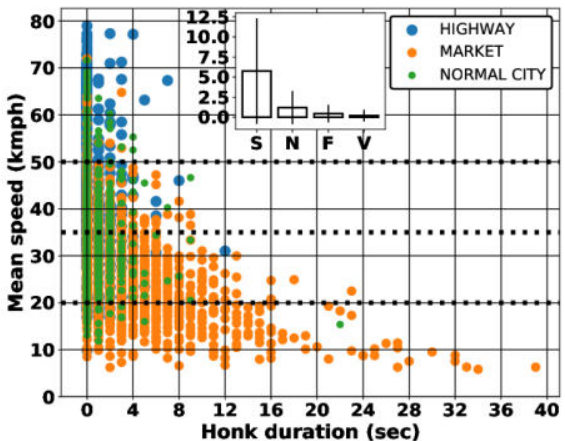
Figure 3. Correlation of H d and mean speed of